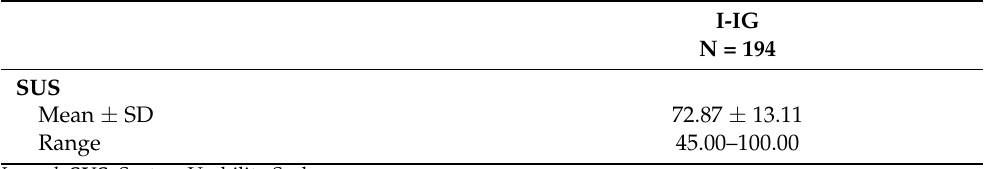
Table 3. Usability and functionality of internet-based psychological